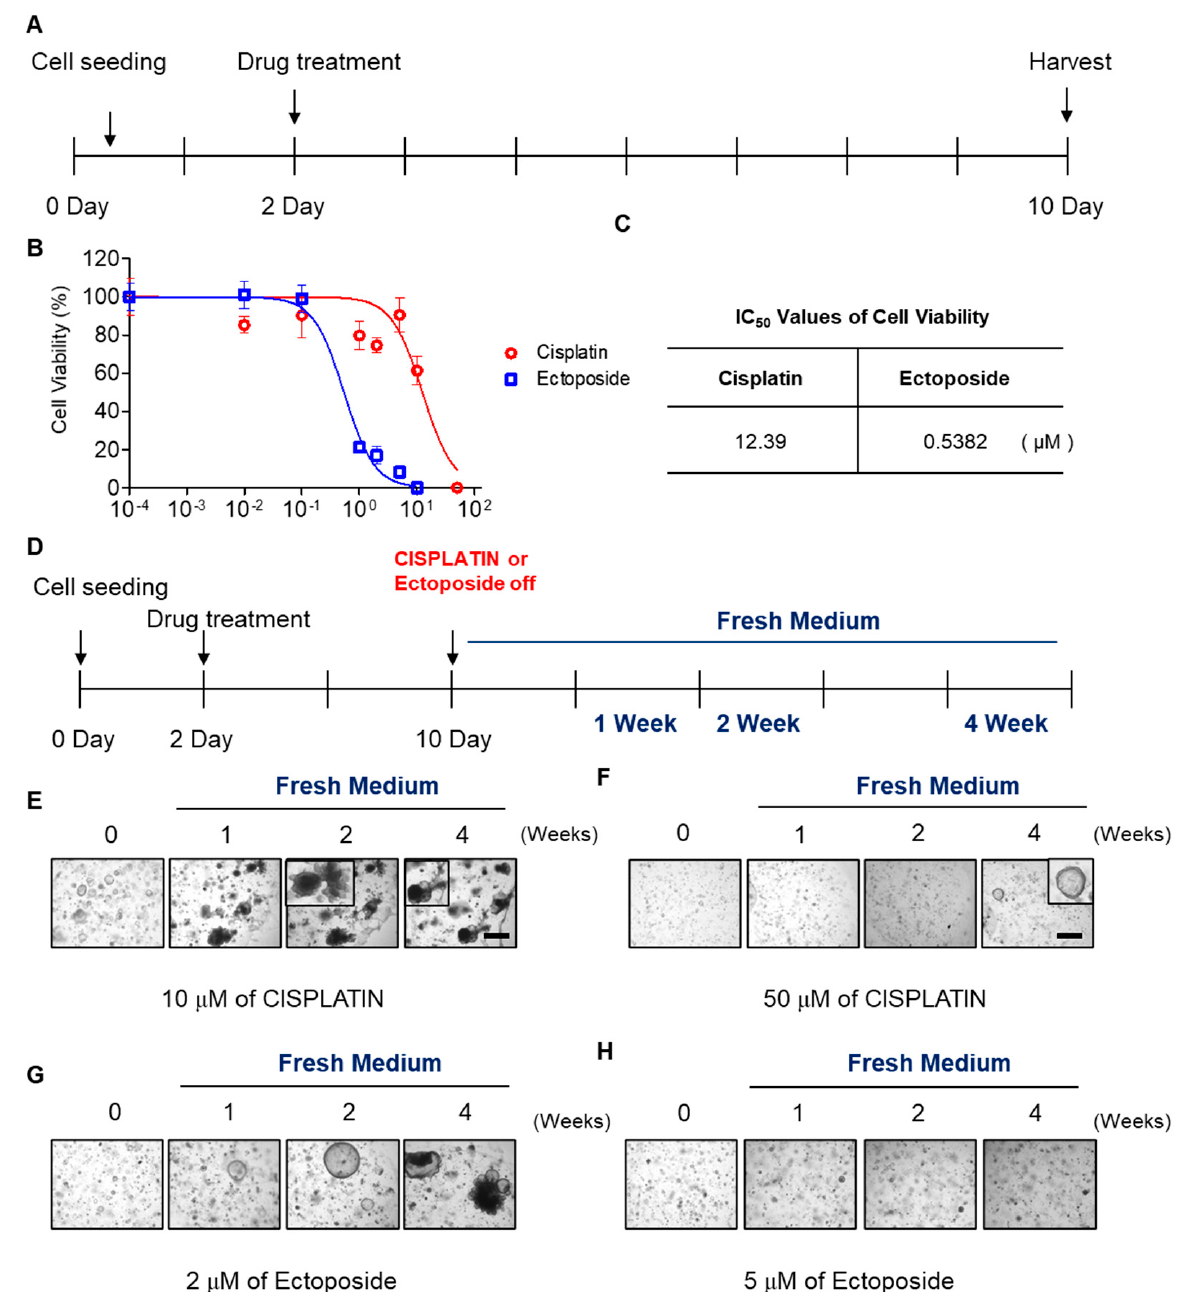
Figure 4. Development of SPDTO as a drug screening assay. SPDTO #7 was treated with various concentrations of cisplatin or etoposide for 8 days then organoids were transferred to fresh medium for 4 weeks. ( A ) Cisplatin or etoposide treatment schedules. ( B ) IC 50 graph of cisplatin and etoposide with SPDTO #7. ( C ) IC 50 values for cisplatin and etoposide with SPDTO #7 ( D ). Schedules for monitoring SPDTO #7 after withdrawal of cisplatin or etoposide for 4 weeks, monitored in fresh medium at 1, 2, and 4 weeks. ( E – H ) Bright-field images of SPDTO #7 grown in fresh medium after treatment with 10 µ M cisplatin ( E ), 50 µ M cisplatin ( F ), 2 µ M etoposide ( G ), or 5 µ M etoposide ( H ). Scale bars represent 75 µm.